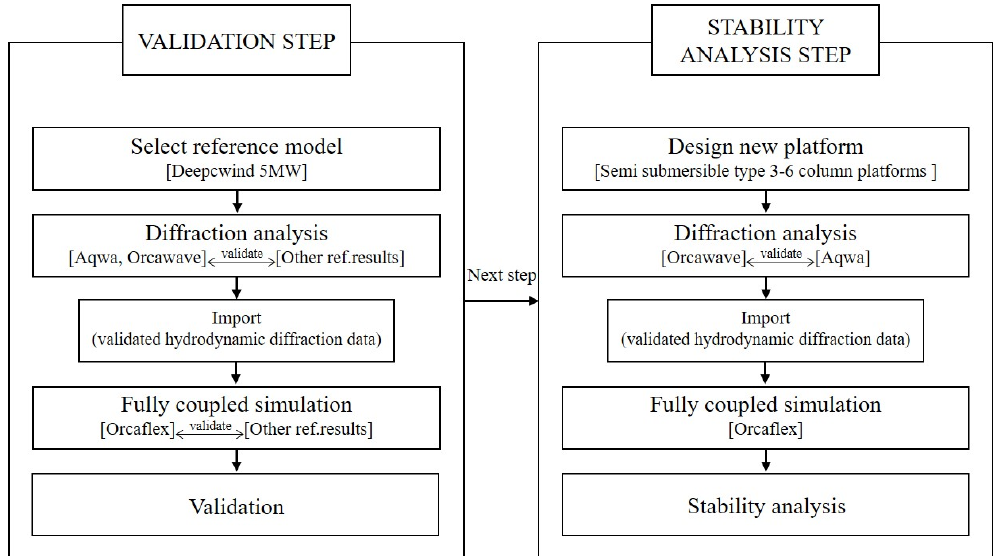
Figure 1. Workflow of the present simulation.